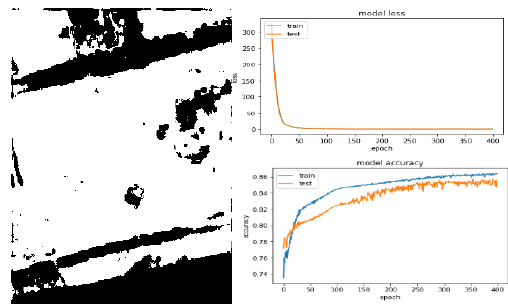
Figure 10 . Test 2 predictions: segmented image, model